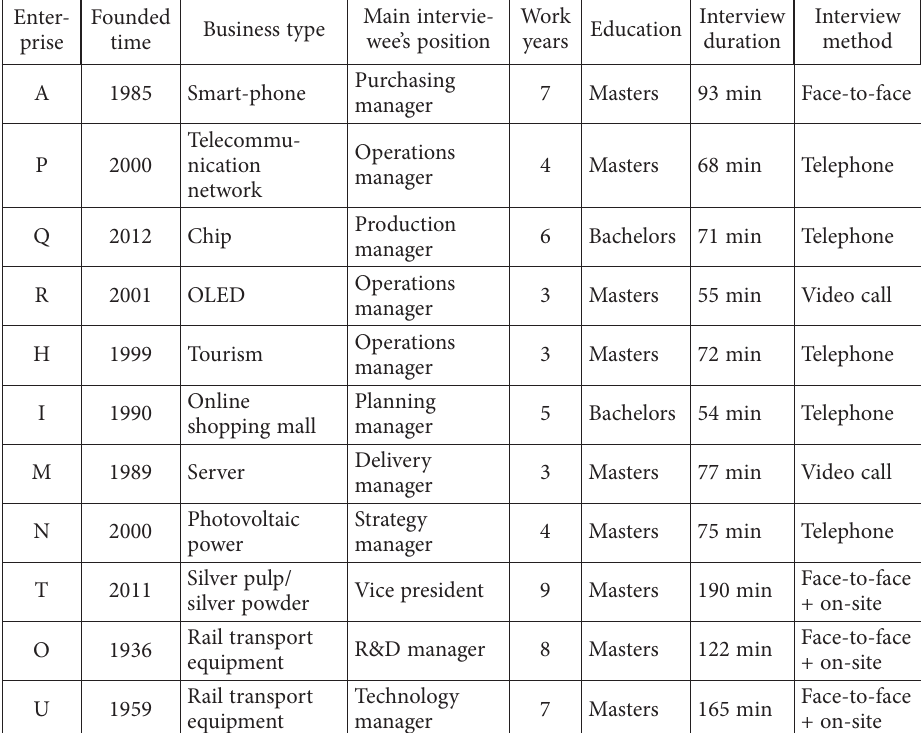
Table 1. Interview samples